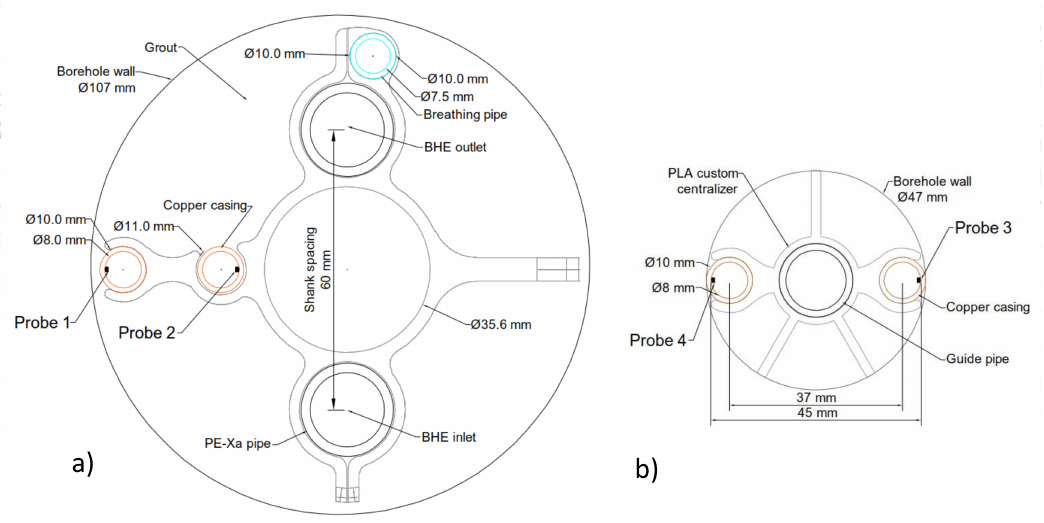
Figure 3. The cross-sectional view of ( a ) the experimental borehole, EXBH, with the BHE layout; and ( b ) the monitoring borehole,